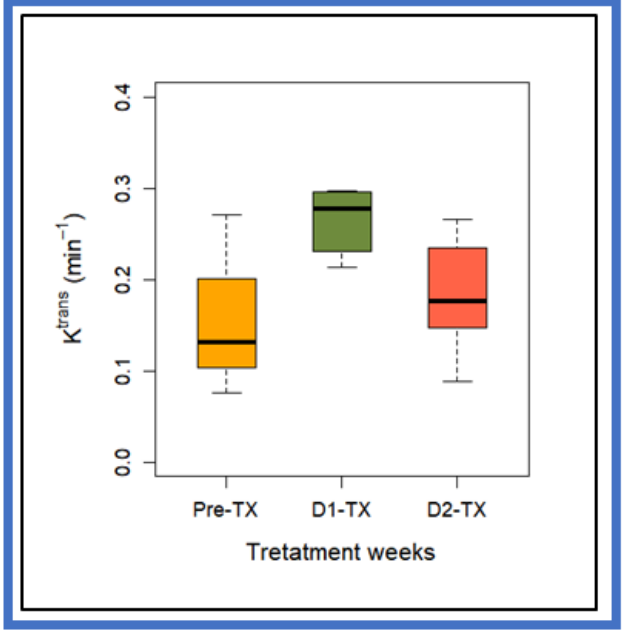
Figure 2. Box-and-whisker plot comparing volume transfer constant, K trans , values at pre-TX, D1-TX, and D2-TX in PDAC patients treated with stereotactic body radiation therapy. The horizontal black lines in boxes represent the median, and the top and bottom of boxes represent 25% and 75% percentiles of data values, respectively. Mean K trans value at D1-TX was significantly different from pre-TX and D2-TX ( p = 0.005 for Pre-TX and p = 0.01 for D2-TX). Pre-TX and post-TX K trans values did not reach statistical significance ( p > 0.05).